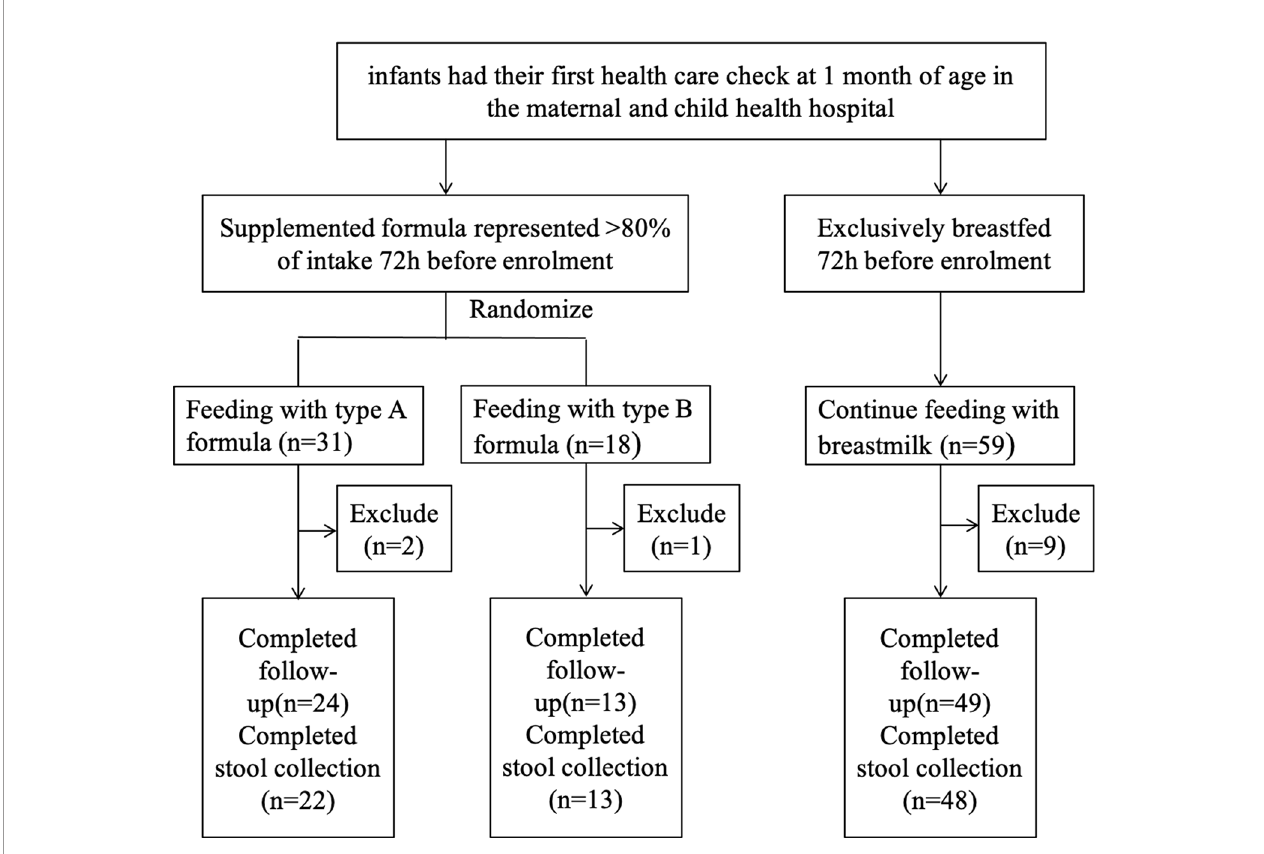
FIGURE 1 | Study fl